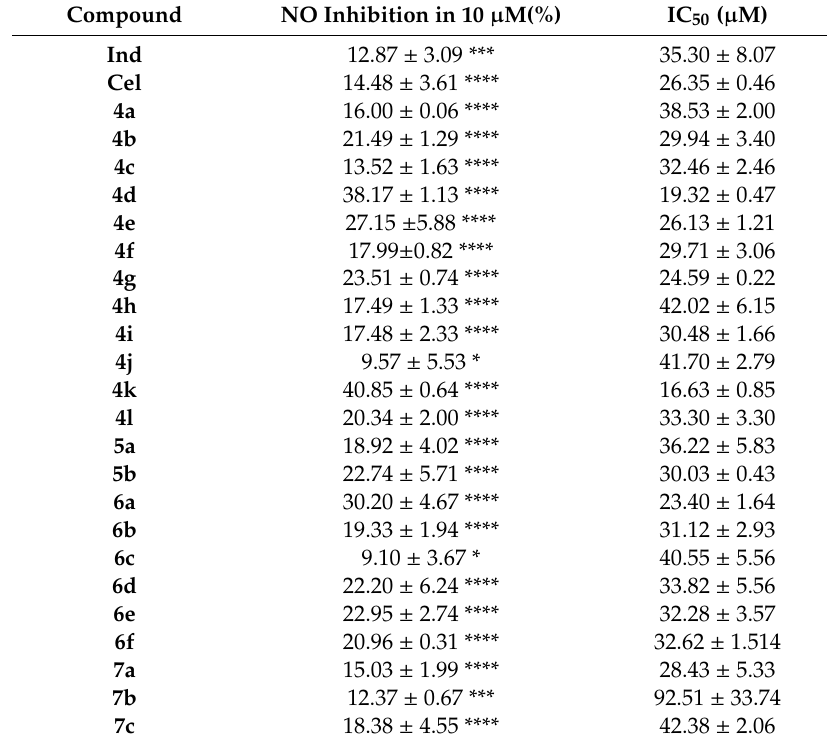
Table 3. IC 50 and Inhibition rate on NO production in LPS-treated RAW264.7 cells at the compound concentration of 10 µ